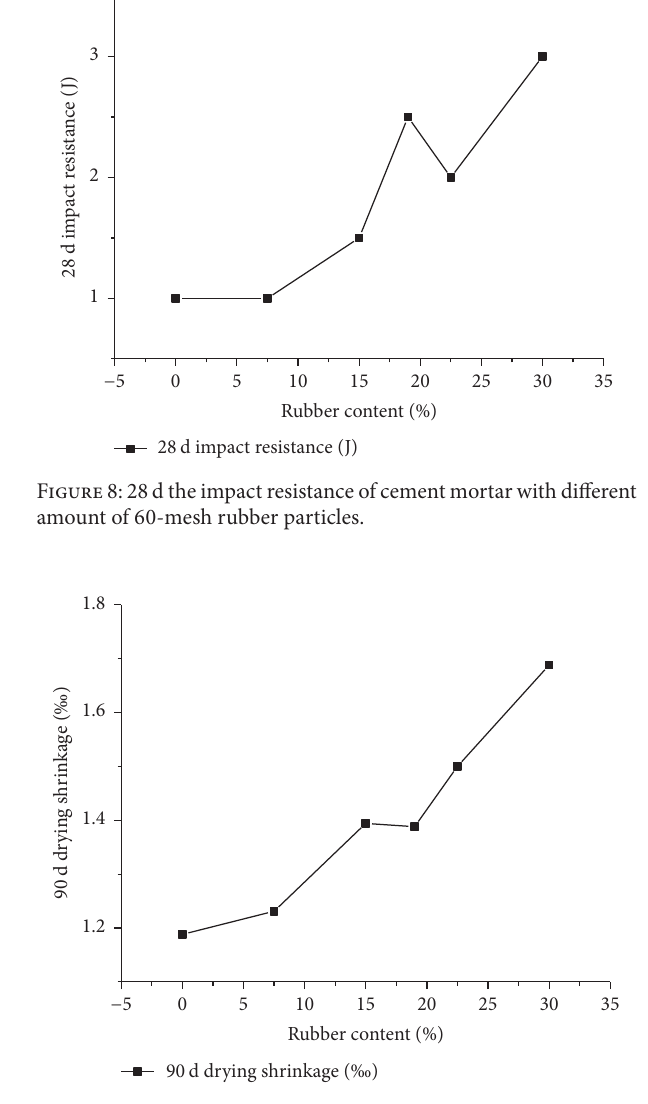
Figure 9: 90 d the drying shrinkage of cement with amount of 60- mesh rubber particles